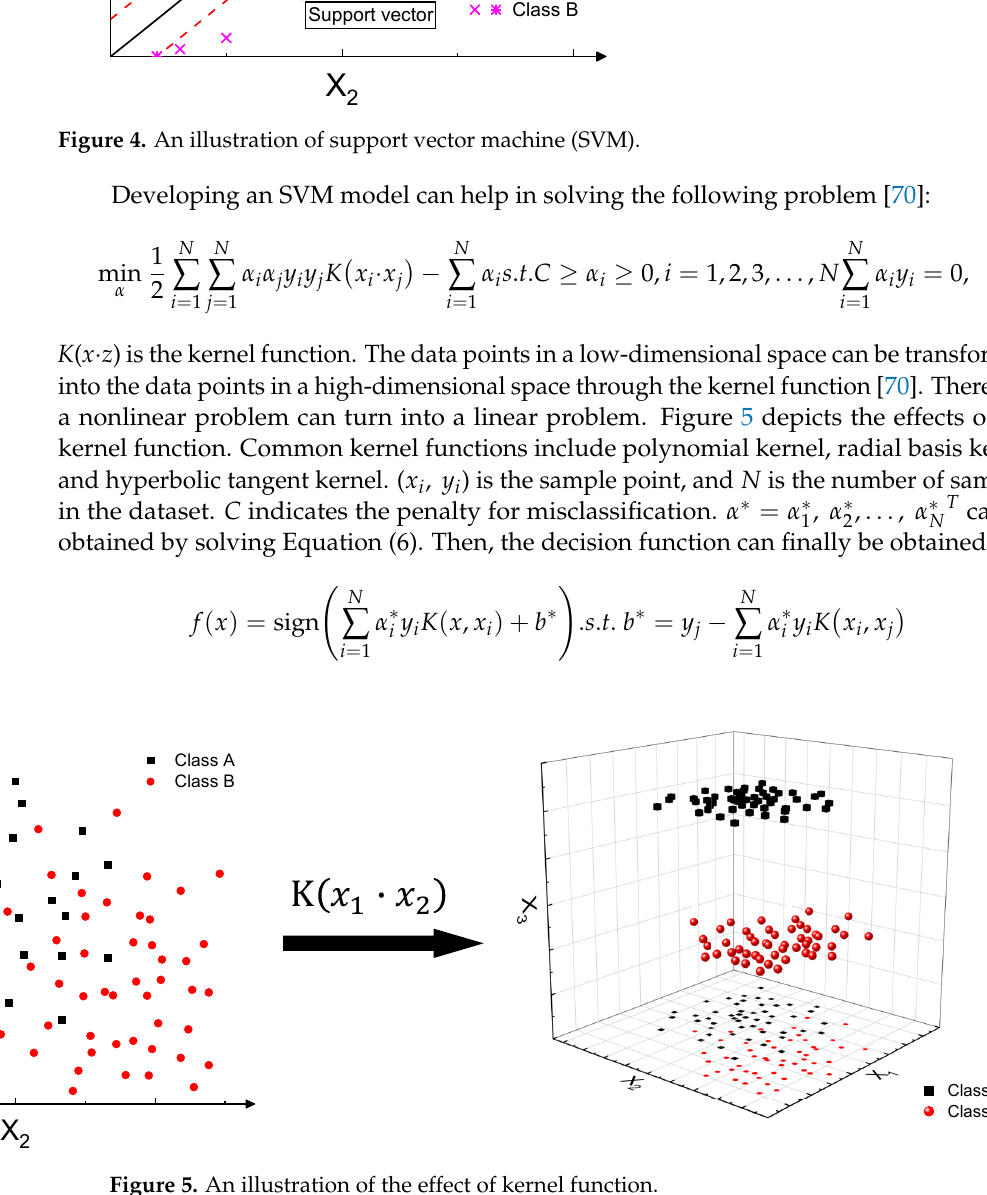
Figure 5. An illustration of the effect of kernel function.